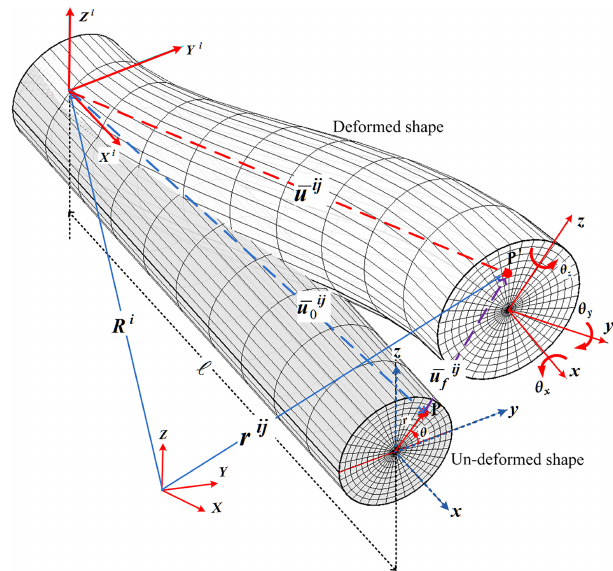
Figure 2. Beam element of circular cross section within FFR for-